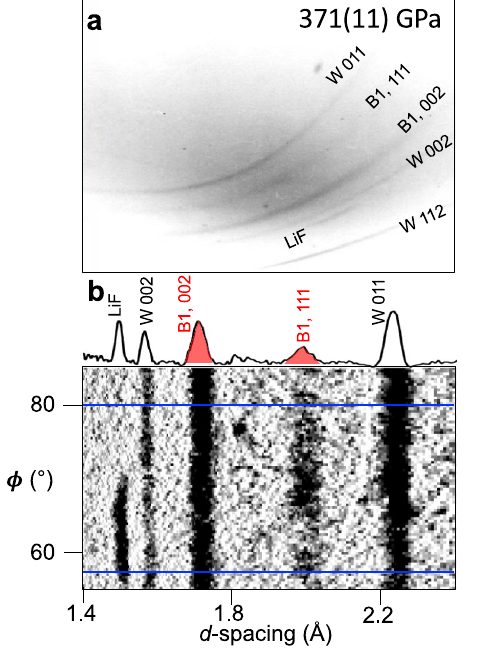
Fig. 2 X-ray diffraction pattern for a representative experiment on SiC (shot #27430). a One panel of an unprocessed image plate. b Projection of the above image plate into d- spacin g- ϕ space after background subtraction. The one-dimensional X-ray diffraction pattern shown on the upper axis represents integration in ϕ over the region between the blue lines. The textured diffraction from LiF can be distinguished from the more extended features from either the W pinhole or B1 SiC.